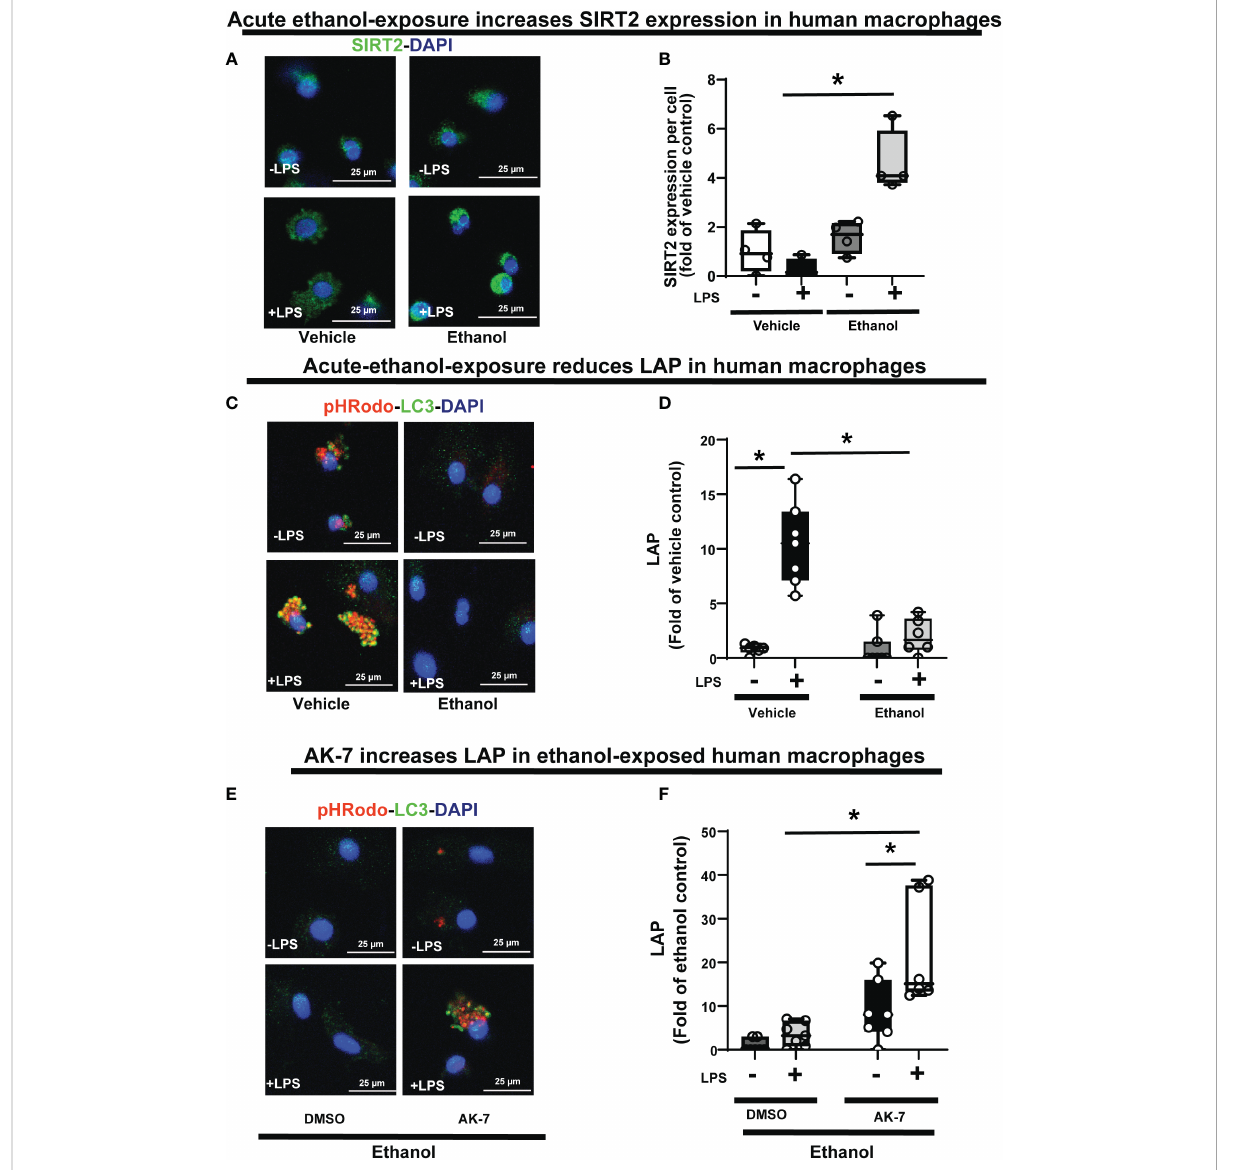
FIGURE 11 The effect of acute ethanol-exposure on SIRT2 expression and the effect of AK-7 on LC3-associated phagocytosis in Ethanol-exposed Human macrophages. Human macrophages were exposed to vehicle or ethanol ± LPS to study SIRT2 expression and LAP. SIRT2 expression was analyzed by immunostaining (A) Representative images of SIRT2 immunostaining in vehicle or Ethanol-exposed human macrophages ± LPS. (B) Fluorescence quanti fi cation of SIRT2 immunostaining in human macrophages (n=4; *p<0.05). (C) LAP in human macrophages with vehicle or ethanol-exposure ± LPS. Representative images of intracellular pHrodo bioparticles during phagocytosis and co-stained for LC3. (D) For each image, the co-localization of intracellular pHrodo (red) and LC3 (green) were determined as LAP and divided by the total numbers of nuclei. Graph represents fl uorescence quanti fi cation of LAP in human macrophages (n=4; * p<0.05). (E) Ethanol-exposed human macrophages were co-treated with SIRT2 inhibitor AK-7 or DMSO ± LPS. Representative images of intracellular pHrodo bioparticles during phagocytosis and stained for LC3 to study LAP. (F) Graph represents fl uorescence quanti fi cation of LAP in Ethanol-exposed human macrophages ± AK-7 ± LPS stimulation (n=4; *